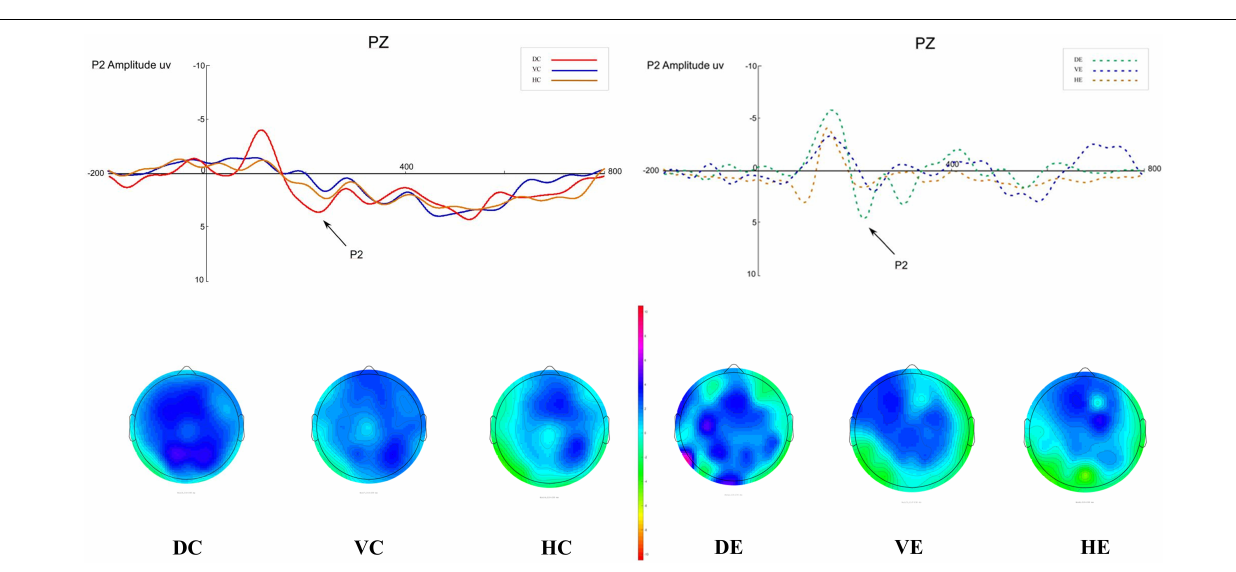
FIGURE 4 | ERP waveforms of the P2 under three conditions for L2 Chinese (left) and L2 English (right) for PZ parietal leads. VC, Viewing Chinese; HC, Hand Writing Chinese; VE, Viewing English; HE, Hand Writing English; DC, Drawing followed by Chinese Word Recognition; DE, Drawing followed by English Word Recognition. Topographic maps of experimental